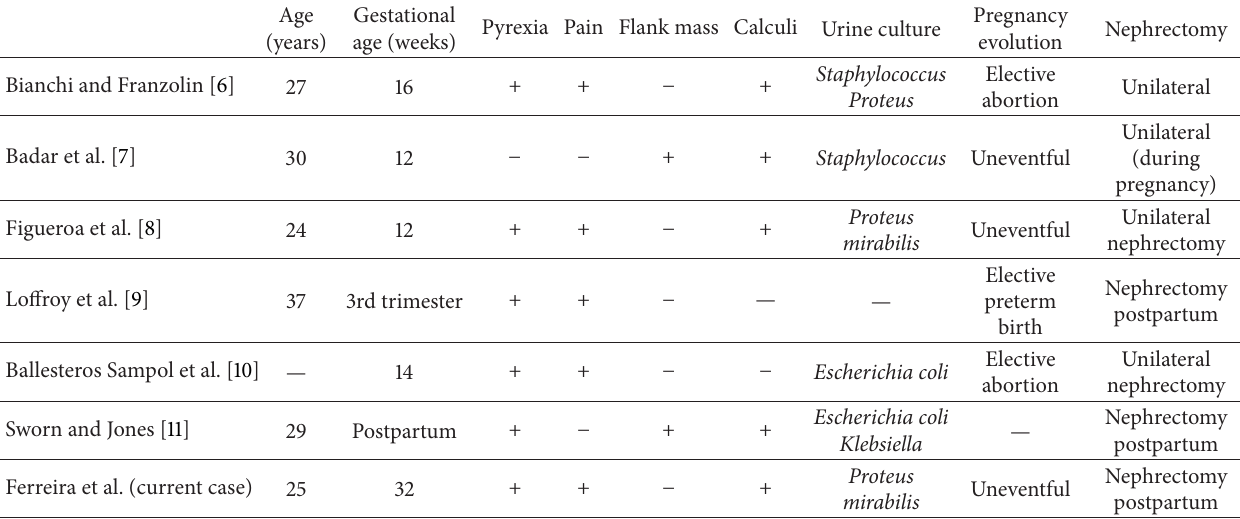
Table 1: Comparison of published